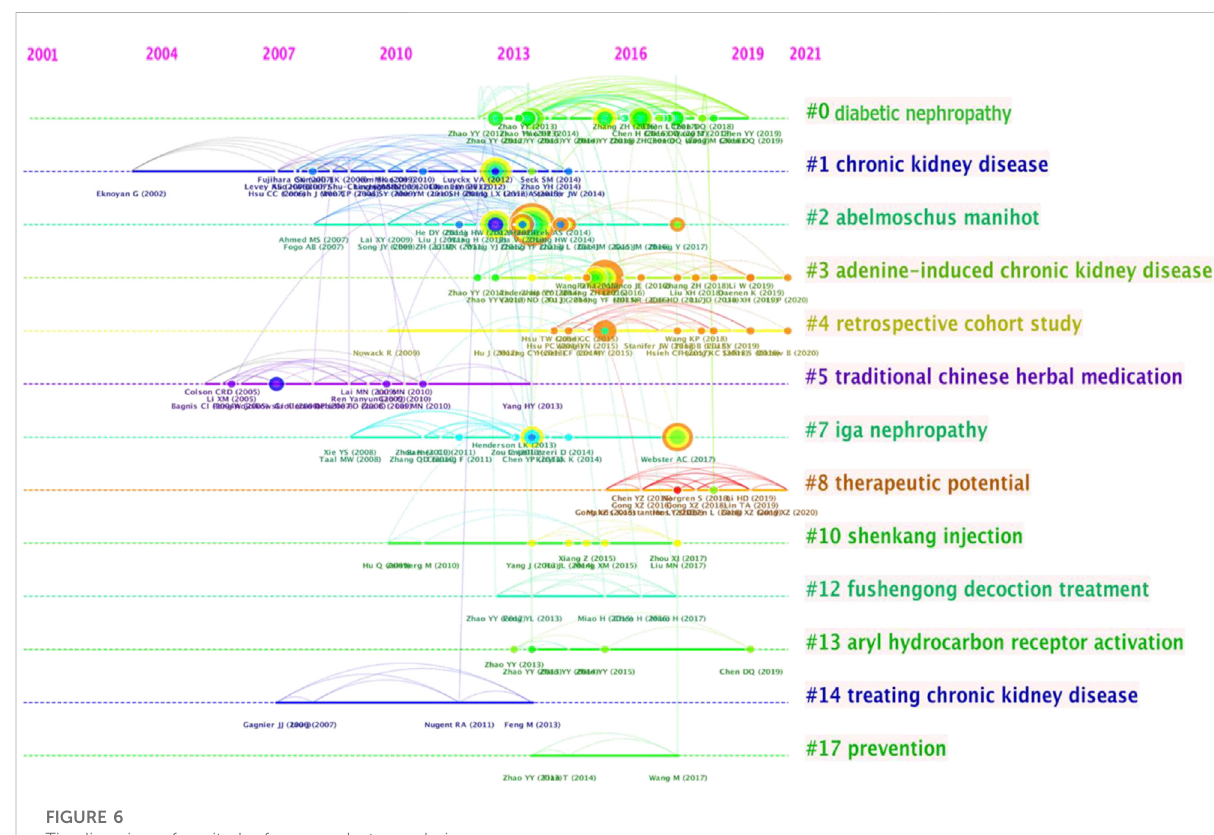
FIGURE 6 Timeline view of cocited references cluster